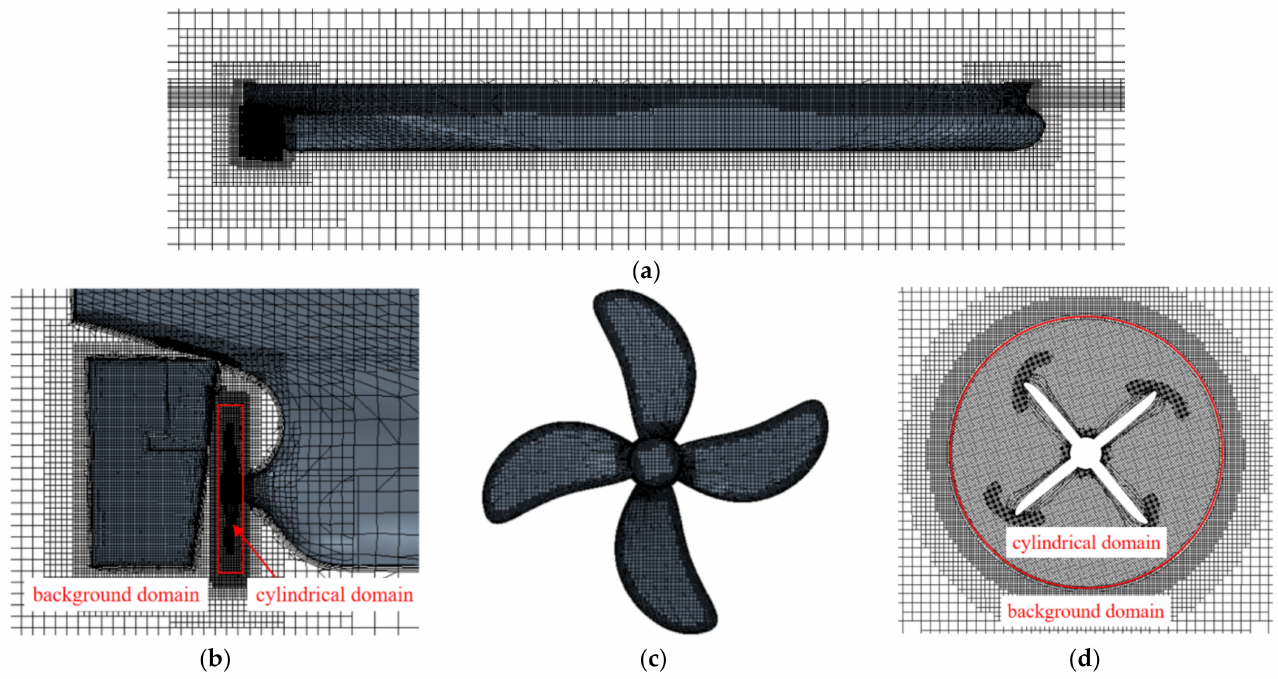
Figure 4. Mesh distributions. ( a ) Side view of the mesh around the hull; ( b ) Meshes around the stern; ( c ) Surface meshes of the propeller; ( d ) Meshes at the propeller